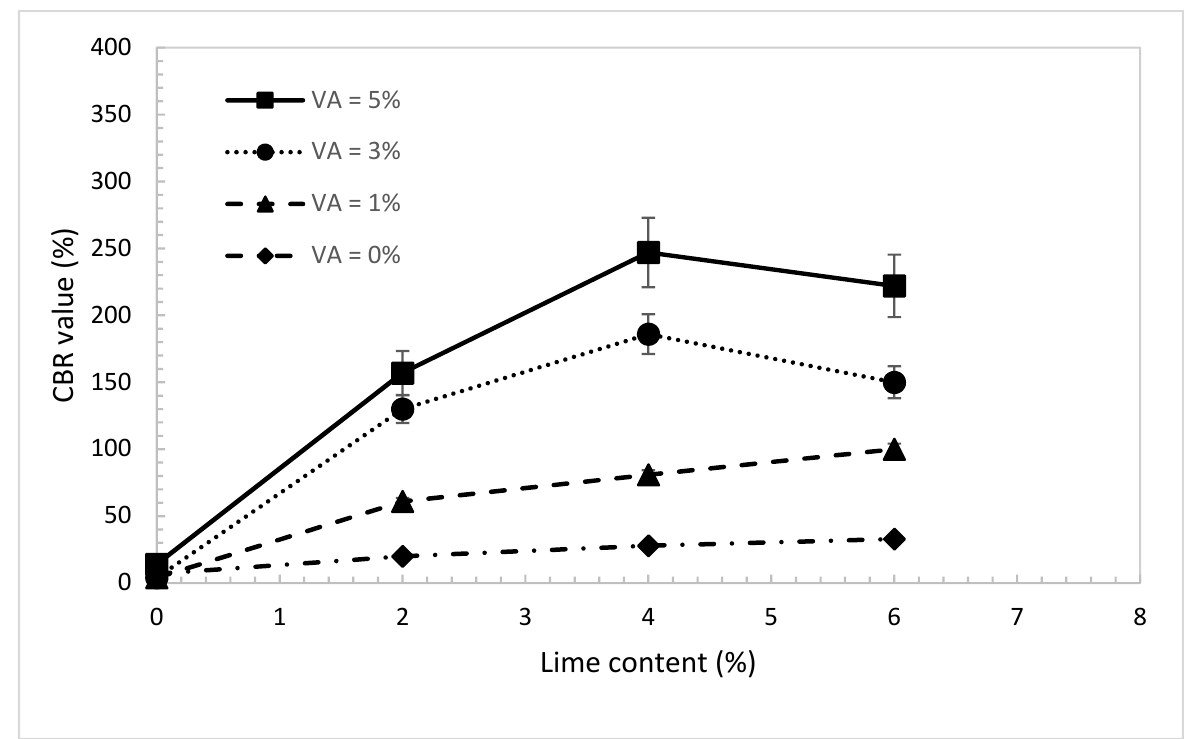
Figure 14. CBR value of the treated dune sand vs. lime content for different percentages of volcanic ash.